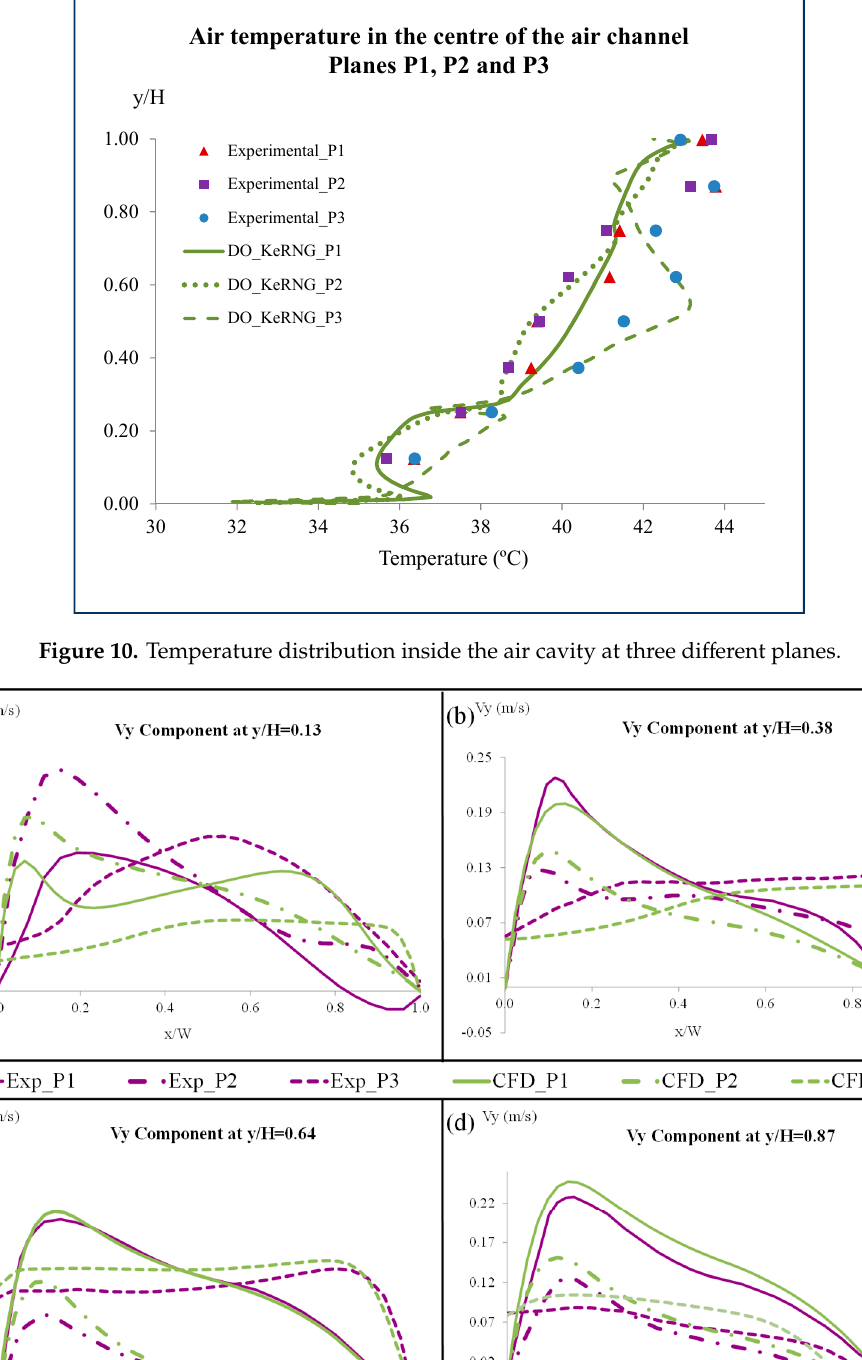
Figure 11. Vertical velocity component of airflow inside the ventilated cavity at different heights: ( a ) y/H = 0.13, ( b ) y/H = 0.38, ( c ) y/H = 0.64 and ( d ) y/H = 0.87.